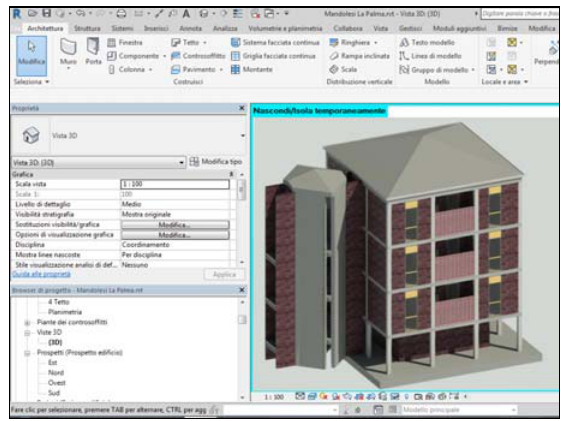
Figure 4. The informative model BIM developed in Revit